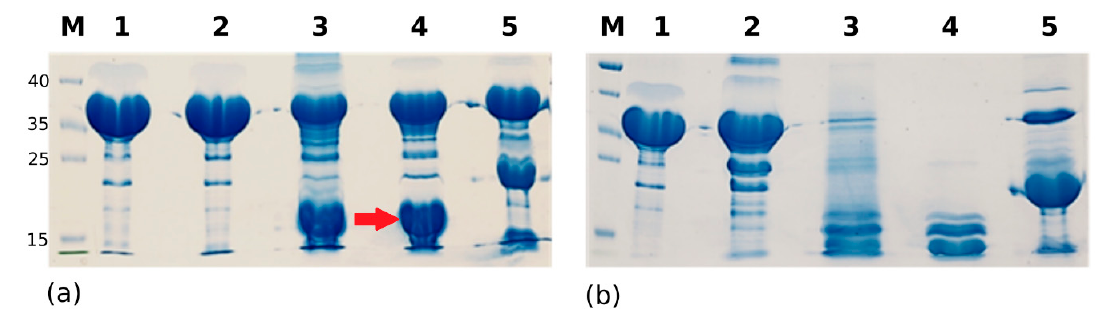
Figure 2. Limited proteolysis of SpEIIAB-Man: ( a ) 10% SDS-PAGE of SpEIIAB-Man after incubation with proteases at 1:1000 molar ratio: lane 1—untreated protein (control), treated with: lane 2—chymotrypsin, lane 3—papain, lane 4—subtilisin (with EIIA domain indicated with red arrow), lane 5—trypsin. ( b ) Same as panel ( a ), but with proteases at 1:100 molar ratio.